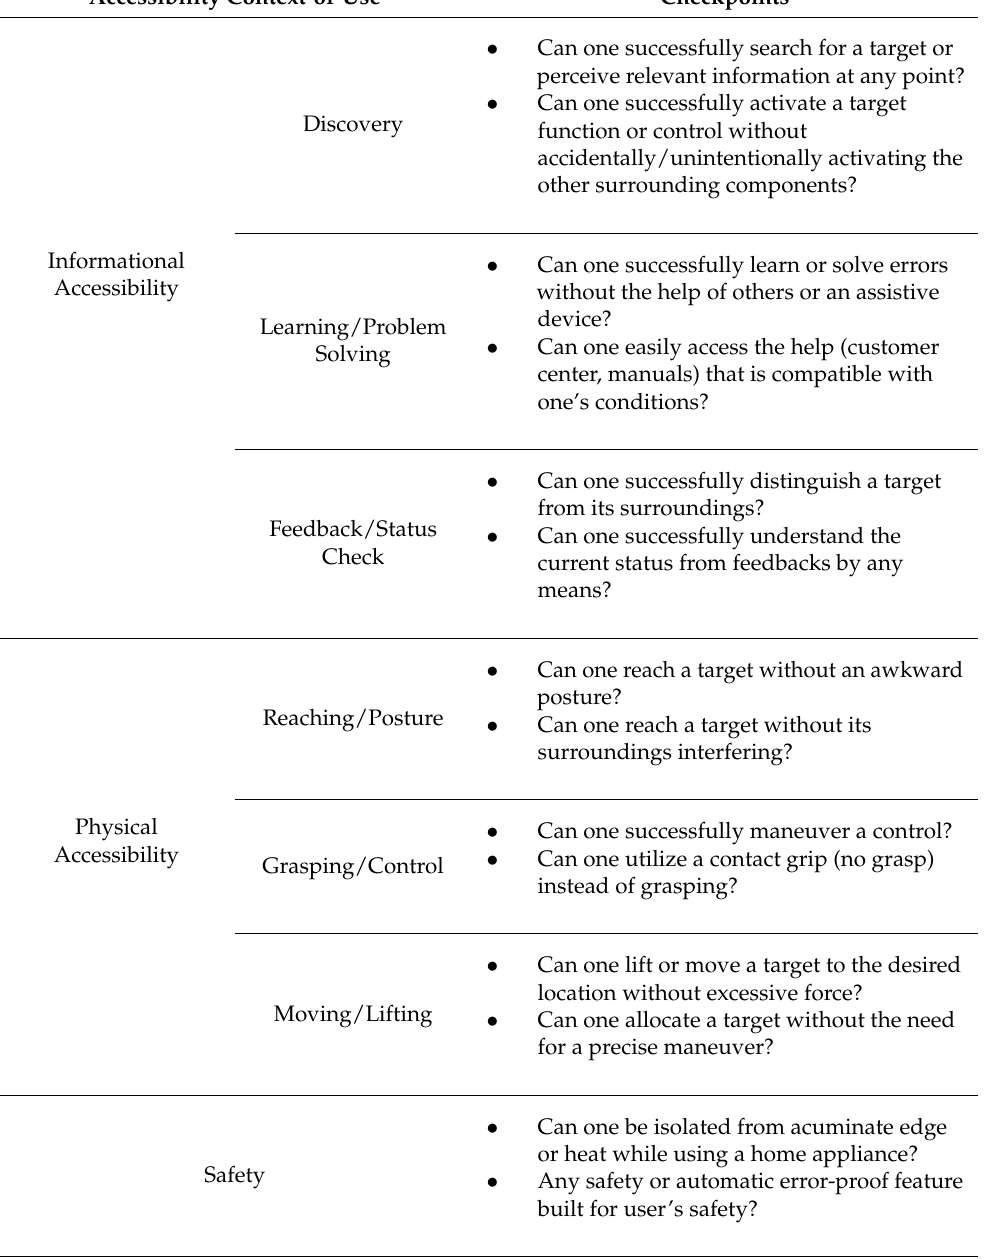
Table A1. Accessibility checkpoints for the home appliance